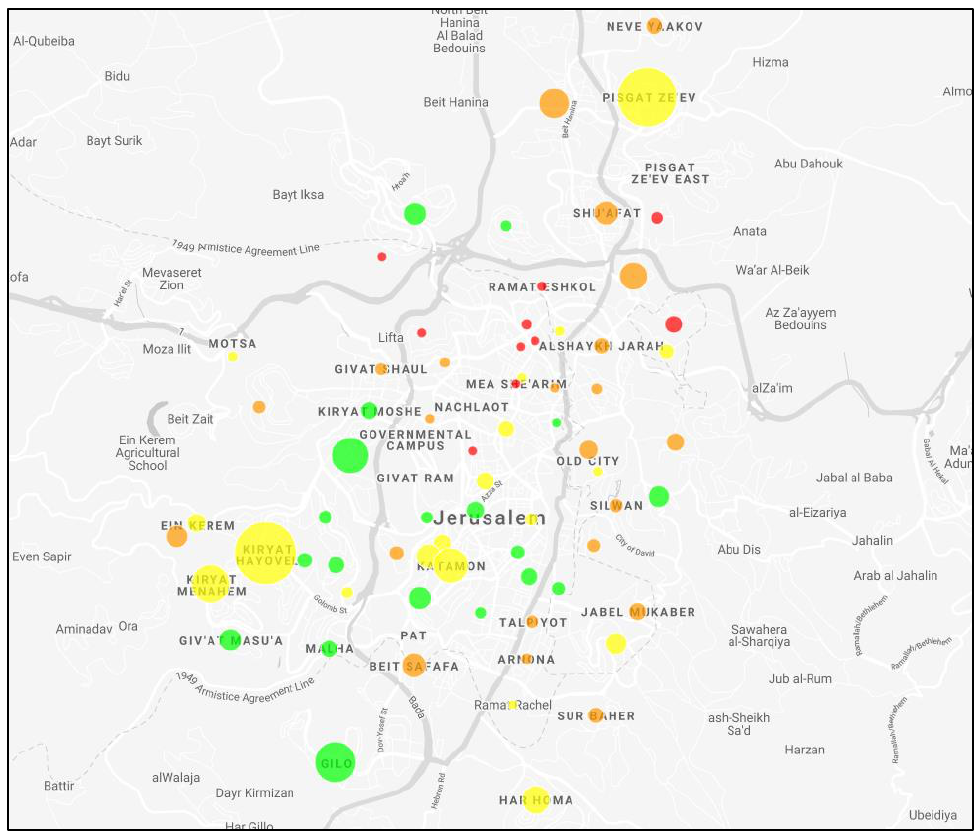
Figure 4. Heat map of SARS-CoV-2 prevalence in Hadassah workers in Jerusalem. Circle size corresponds with number of Hadassah workers and color with SARS-CoV-2 prevalence: green < 5%, yellow 5–10%, orange 10–20%, red > 20%.